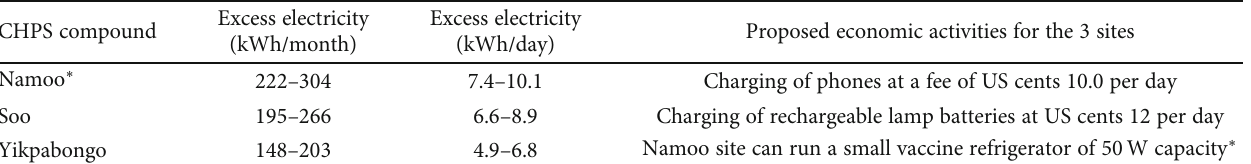
Table 5: Proposed economic activities for the ESCOs for the 3 sites.